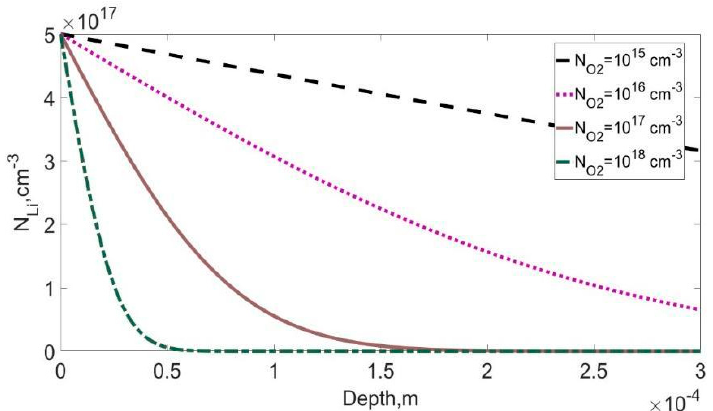
Figure 2. The diffusion profile of lithium into silicon at degrees of oxygen concentration from 10 15 to 10 18 , at a temperature of T = 420 °C.